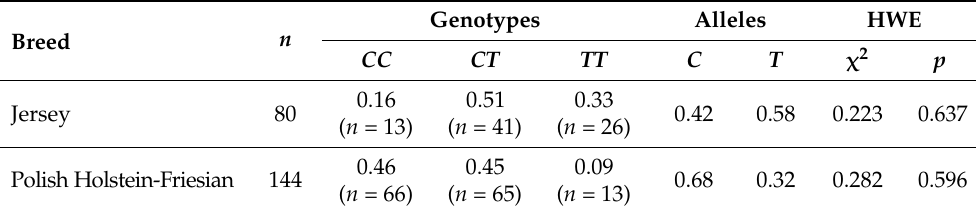
Table 2. Distribution of THRSP genotypes and alleles in analyzed breeds of cows. Genotypes Alleles HWE Breed n